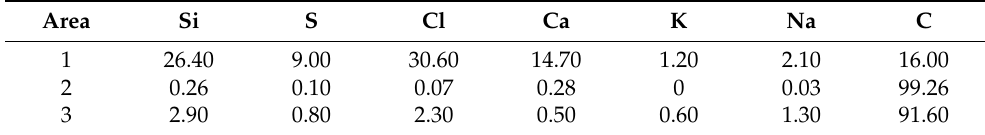
Figure 15. SEM images of the membrane’s surface after completing the MD studies: ( a ) feed: Baltic Sea water, CMD1 module; ( b ) feed: NaCl solution (300 g/L), CMD 3 module. Sea water, CMD1 module; ( b ) feed: NaCl solution (300 g/L), CMD 3 module. Table 3. Concentration (wt.%) of elements forming the deposit. Table 3. Concentration (wt.%) of elements forming the